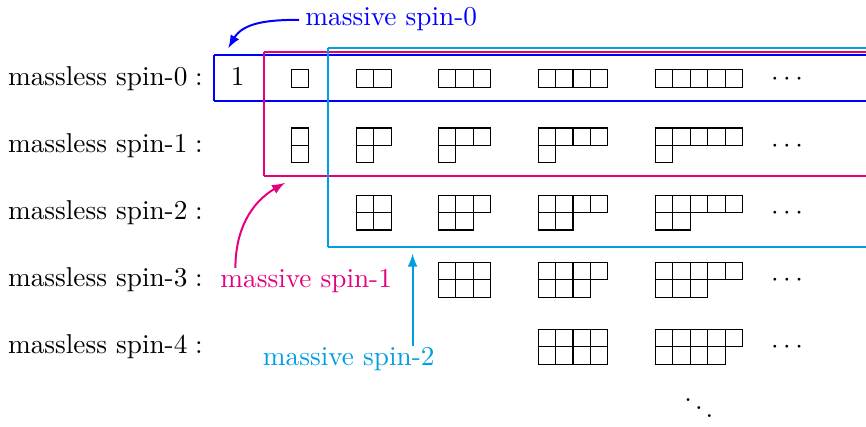
Figure 2 . Mode decomposition of massive and massless single particle modules. The combination of massless SPMs into massive ones reflects the Higgs